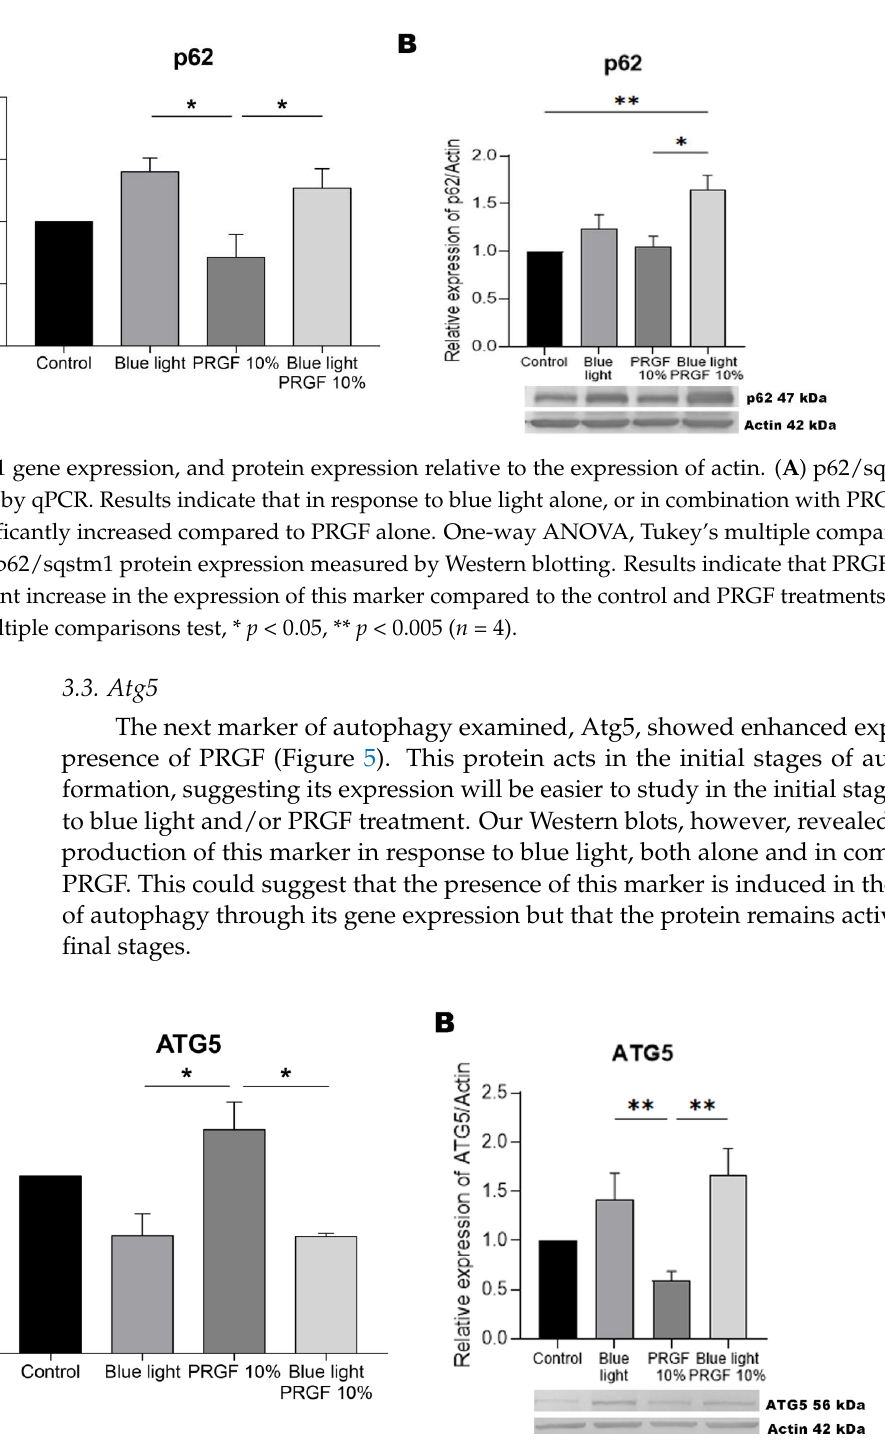
Figure 5. Atg5 gene expression, and protein expression relative to the expression of actin. ( A ) Atg5 gene expression measured by qPCR. Results indicate that in the presence of PRGF, its gene expression was significantly increased compared to the blue light treatment, combined or not with PRGF. One-way ANOVA, Tukey’s multiple comparisons test, * p < 0.05 ( n = 4). ( B ) Atg5 protein expression measured by Western blotting. Results indicate that blue light, alone or combined with PRGF, led to a significant increase in the expression of this marker compared to the PRGF treatment. One-way ANOVA, Tukey’s multiple comparisons test, ** p < 0.005 ( n = 4).